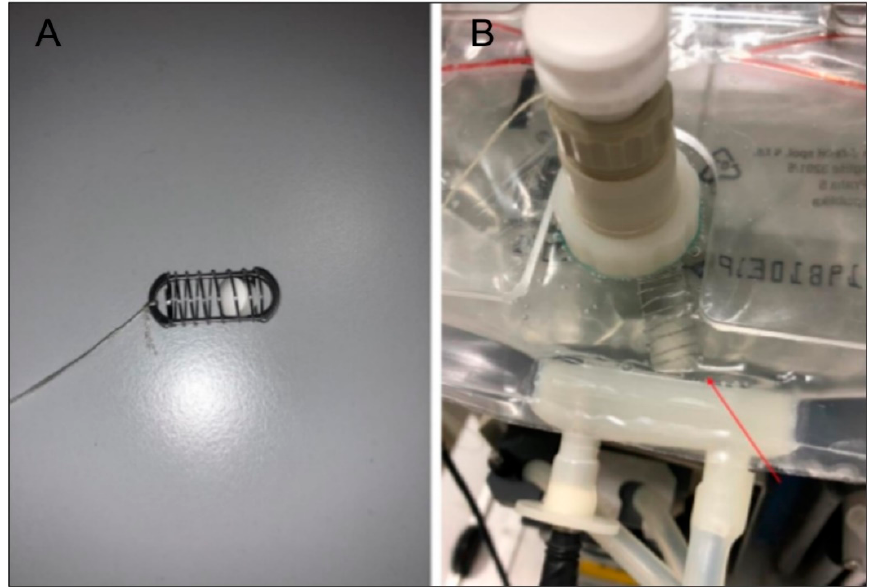
Figure 3. Sinker with incorporated tablet ( A ), sinker with a tablet inside of the bag ( B ).